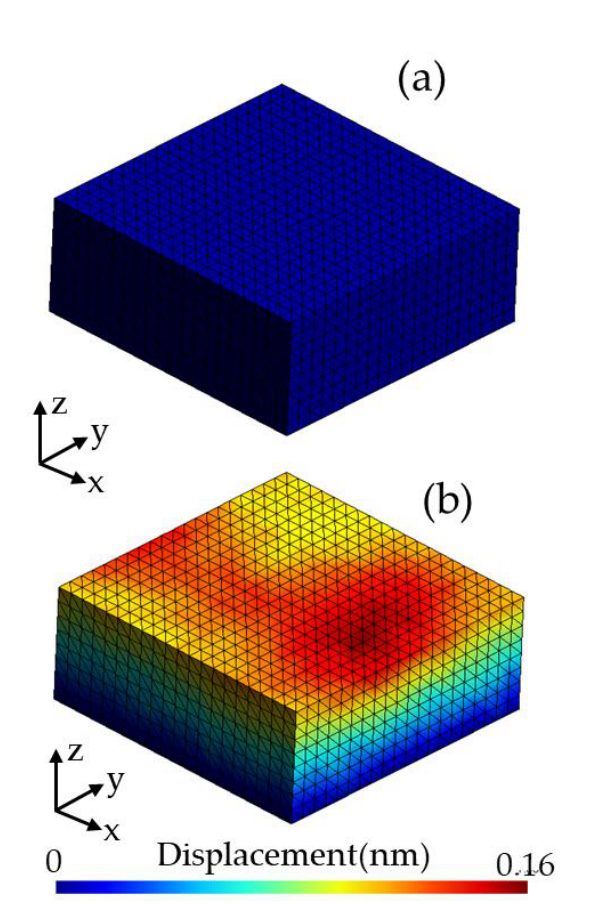
Figure 7. Deformation of the FEM region ( a ) before compression and ( b ) after compression for dry contact.